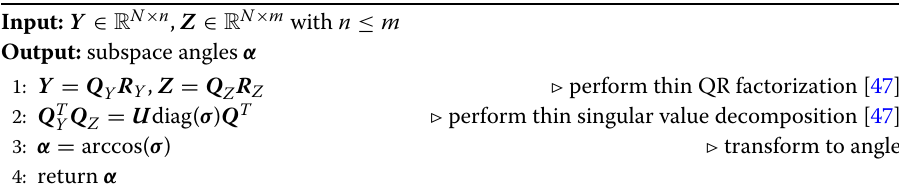
Algorithm 3 SSA( Y , Z ) (computation of subspace